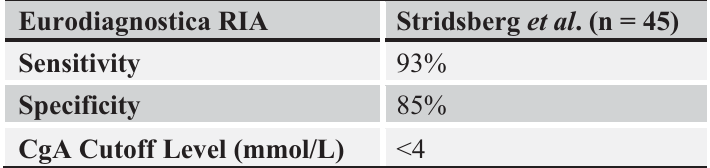
Table 9. Sensitivity and specificity of CgA (Eurodiagnostica RIA